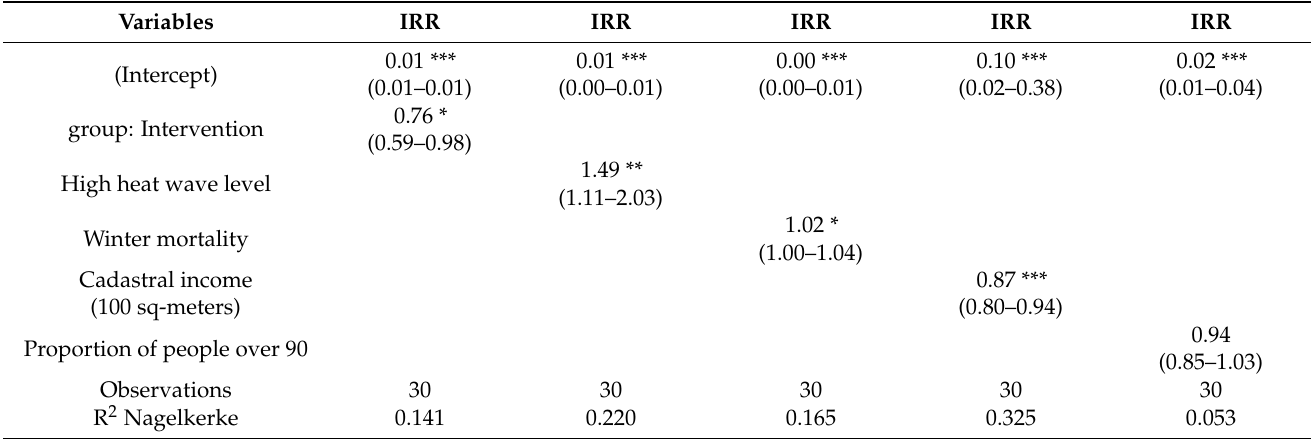
Figure 2. Excess mortality during the summer period with respect to 2014 per year (intervention vs. controls). In 2014, there were 96 and 64 deaths, respectively, in the over-80 population in the intervention and control neighborhoods. In the following 5 years, the excess deaths were 102 (intervention) and 119 (controls) with a rate of 2.70% vs. 3.81%. The rate ratio is 0.70 (c.i. 0.54–0.92, p -value 0.01). The results of the univariate Poisson regression for the group (intervention vs. control), level of heat waves (high-level vs. low-level), winter mortality, and cadastral income per 100 m 2 are shown in Table 2. All variables are associated with the excess mortality rate (except for age > 90), and the variables group and the level of heat wave are those with the greatest effect (IRR 0.76 and 1.49, respectively). Table 2. Univariate Poisson regression. Dependent variable: excess mortality